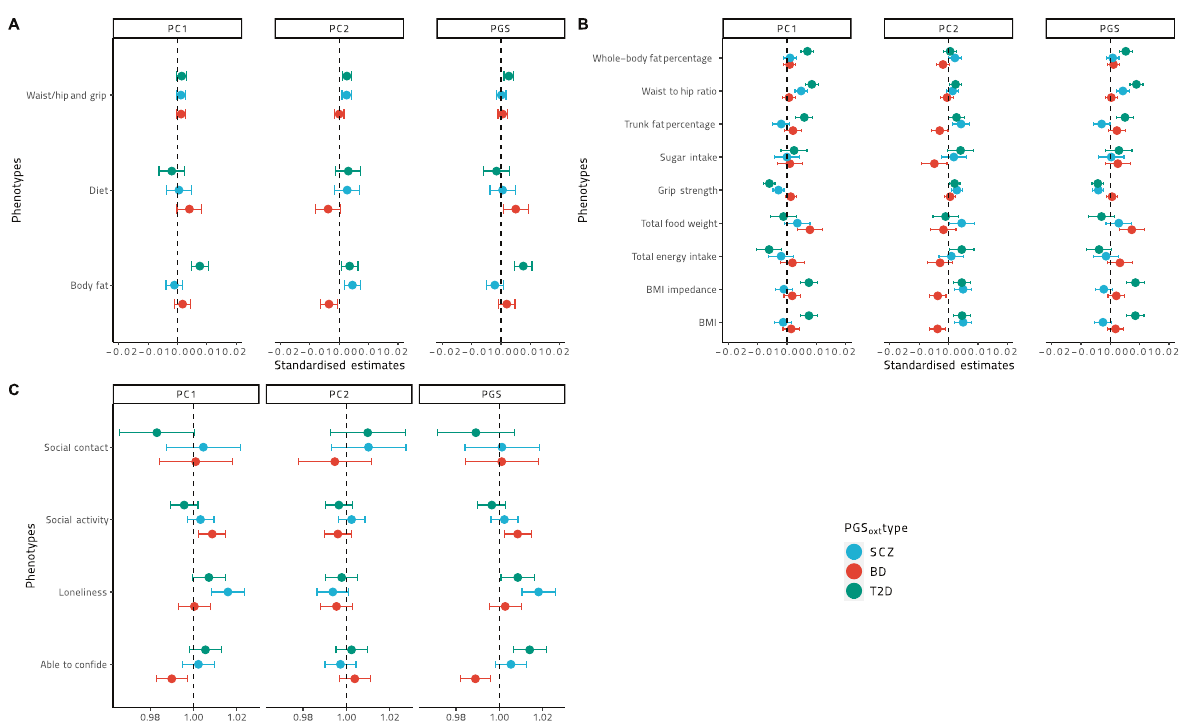
Fig. 3 Effect sizes and con fi dence intervals for the linear models of the cluster principal components continuous phenotypes and logistic regression for the binary phenotypes. A – C Different colors correspond to the three different PGS oxt ’ s and PC – PGS oxt ’ s. BD bipolar disorder, SCZ schizophrenia, T2D type-2 diabetes mellitus, PGS oxt polygenic score for the oxytocin pathway, PC1 fi rst PGS principal component, PC2 second PGS principal